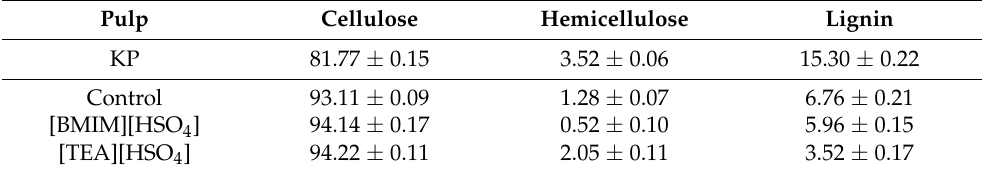
Table 1. The effect of ILs pretreatment on the chemical compositions of eucalyptus kraft pulps during the oxygen delignification process (wt%, based on over-dry pulp weight).